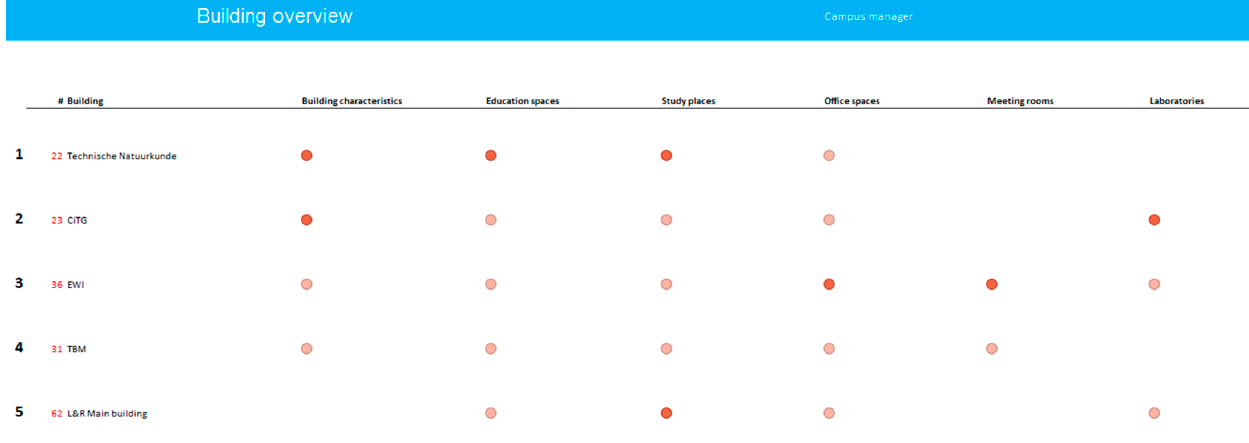
Figure A3. Trends dashboard TU Delft (workshop 2).